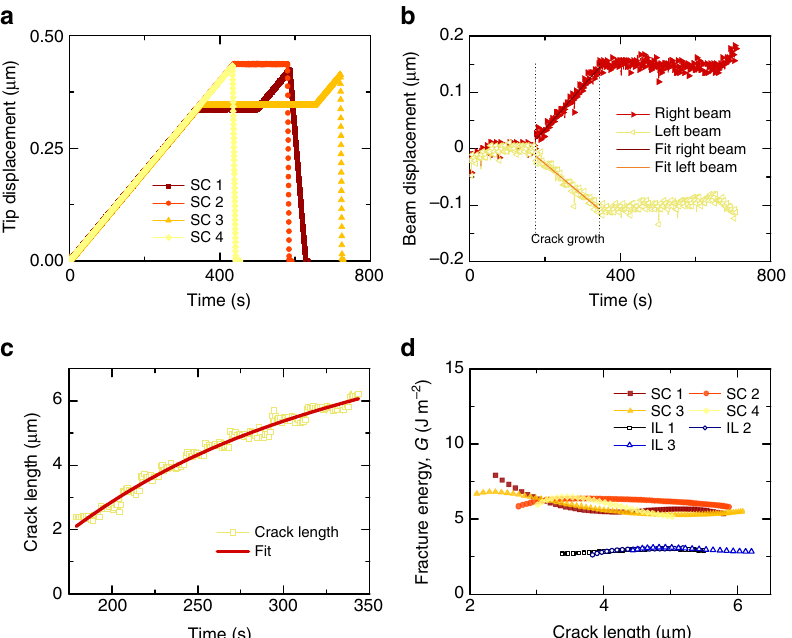
Fig. 3 Data analysis of DCB cracking. a Tip displacements as set-up on the nanoindenter for four of the tests conducted on the single crystal (SC) SiC samples. b Displacement of left and right beams of the sample SC 3 measured by image cross-correlation of the edges during the total test length. Dotted lines are used to show the interval of time in which the crack growth was measured. The curve is fi tted according to a third-order polynomial with R 2 = 0.95 for left beam and R 2 = 0.96 for right beam. c Crack length measured on sample SC 3 from the point of crack nucleation until the tip was stopped to hold position. Fitted data ( R 2 = 0.98) were used for the fracture energy measurement to reduce the noise in the data. d Fracture energy value measured over crack growth for the four SC SiC samples and the three SiC bi-crystals with SiO 2 interlayers (IL), showing good reproducibility and a signi fi cant difference between the values of the two